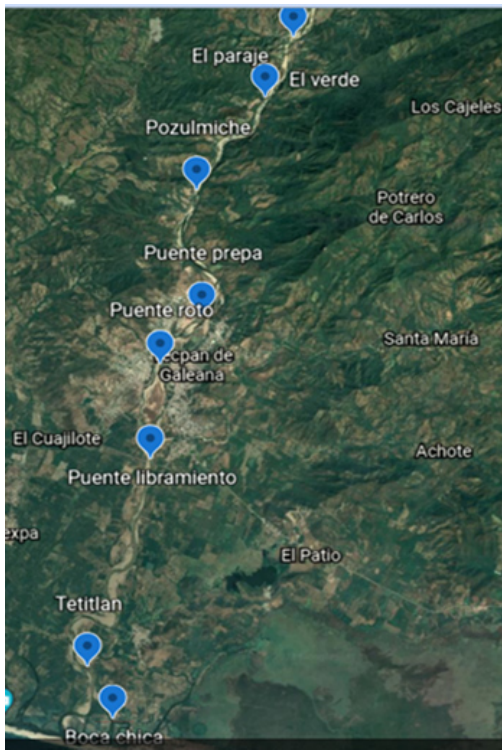
Figure 2. Geographical coordinates of sampling points in the Tecpan River.